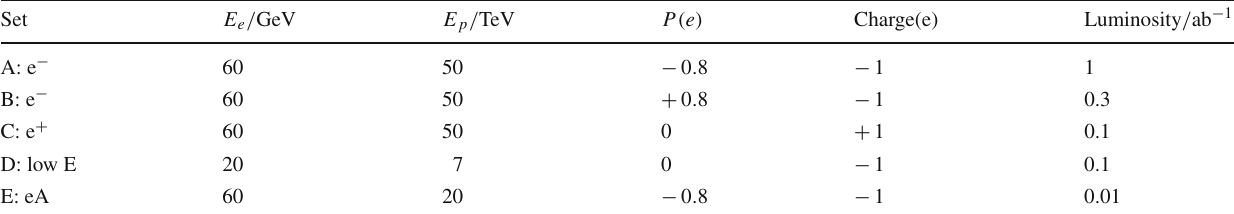
Table 5.2 Assumptions on energy, helicity, electron charge and lumi- nosity for cross section data sets simulated for QCD and electroweak studies on FCC-eh. Basic cuts were applied on the polar angle region